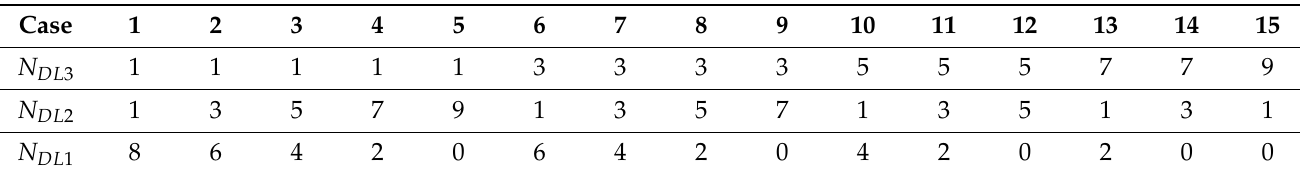
Table 6. The proportion of different discharges levels in the 15 cases.